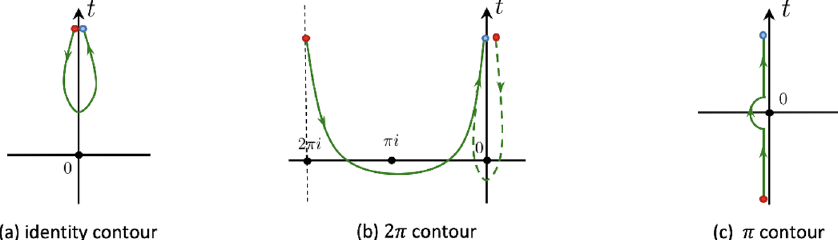
Figure 21 . We display the same contours as in figure 20, but in the t plane. We marked the singularities of the metric (6.4) using black dots. The contour can be smoothly deformed as long as it does not cross the